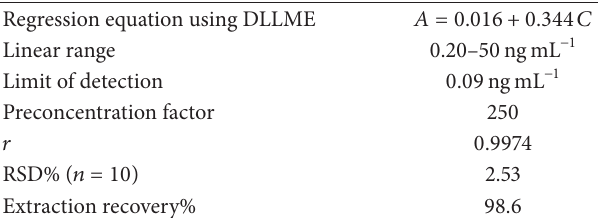
Figure 5: Effect of the extraction time on the analytical responses, conditions: sample volume 5.0mL containing 1.0ngmL −1 Zn(II), dispersive solvent 1.0mL ethanol, extraction solvent 200 𝜇 LCCl 4 containing 2.5 × 10 −6 molL −1 . Table 2: Regression and analytical